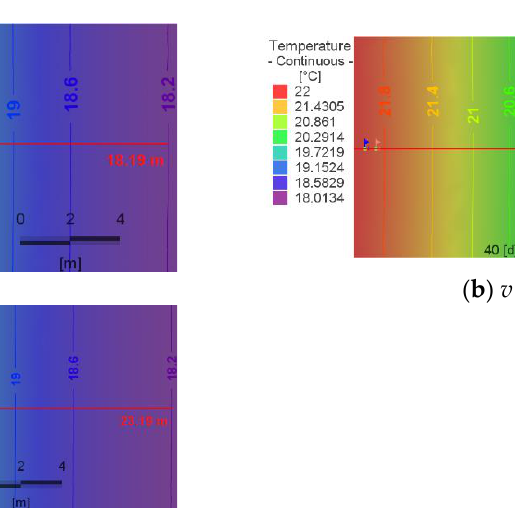
Figure 6. The temperature distribution of the aquifer after 20 days of model operation.